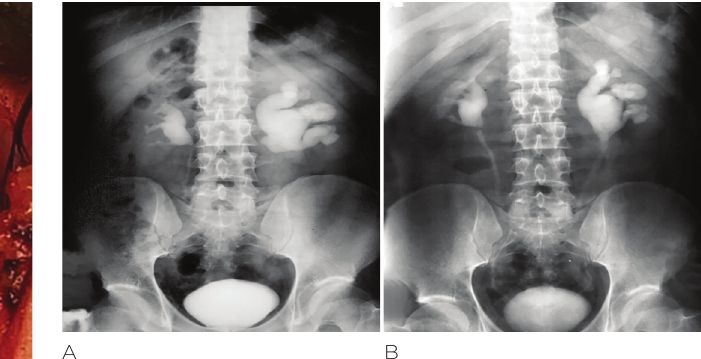
Figure 3. A - Excretory urography - 120 minutes. Left-sided grade III hydronephrosis and right-sided pyeloectasis (grade I hydronephrosis) are revealed. B - Excretory urography - 30 minutes after 1 month subadventital pyeloureteroplasty. It